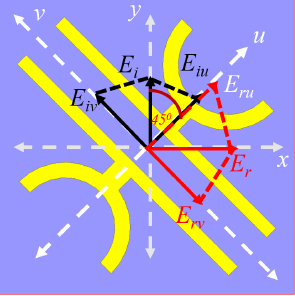
Figure 5. U-V decomposition analysis of the proposed PC.